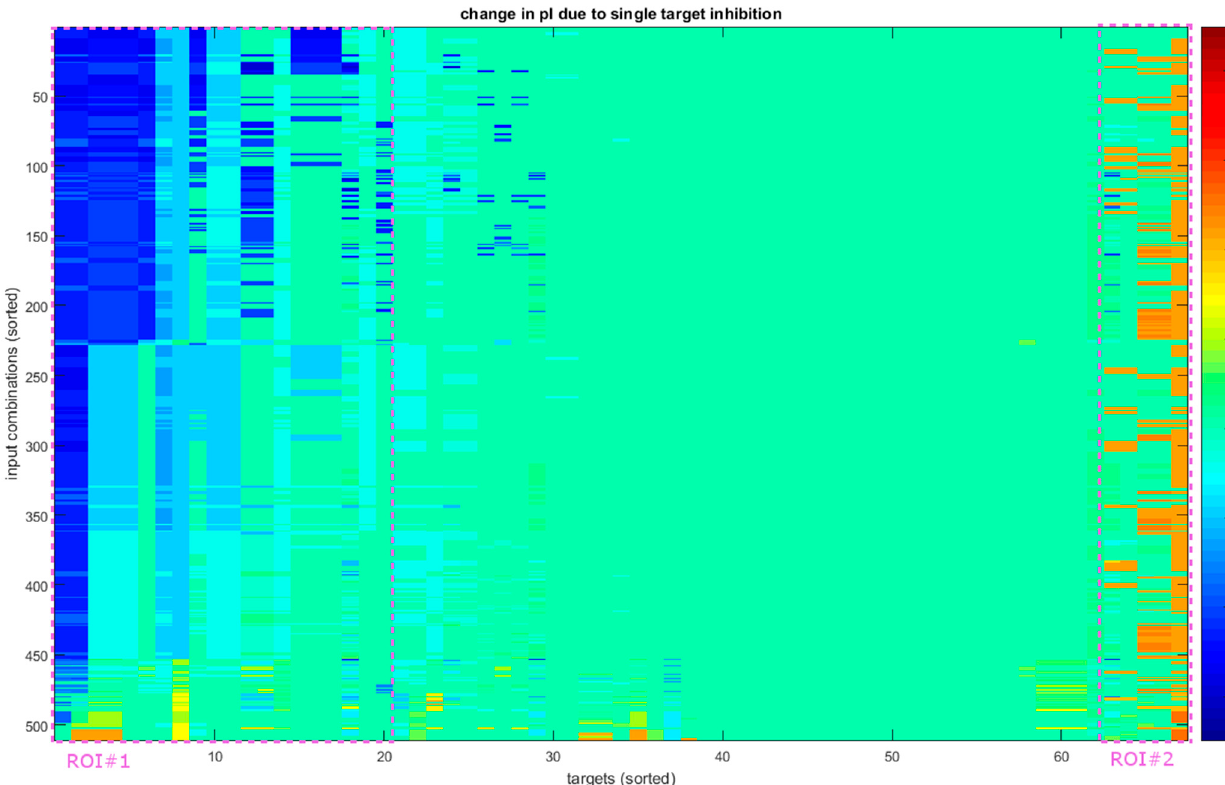
Figure 4. Reactions of the system to single-target inhibition. The vertical axis shows all 511 input combinations and the horizontal all 67 perturbed nodes (direct inhibition of input and output nodes is not performed, extending to receptors with the exception of TLR2 and 4). Both axes are sorted for presentation purposes based on the first principal component of the data. The highlighted areas show the portion of instances that shift predominantly towards a regenerative function (ROI#1) or a more inflammatory one (ROI#2). These only cover approximately 30% and 7% of targets, respectively, and are not homogenous, showing that most inhibitions have a limited effect on the state of the cell.